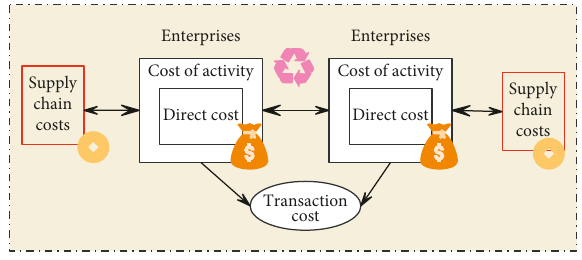
Figure 9: The composition of supply chain